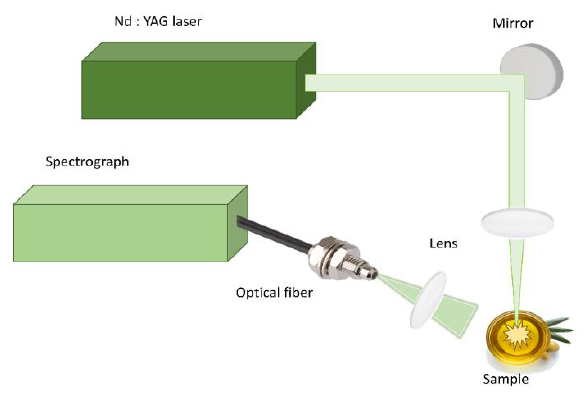
Figure 9. Schematic of the LIBS experimental